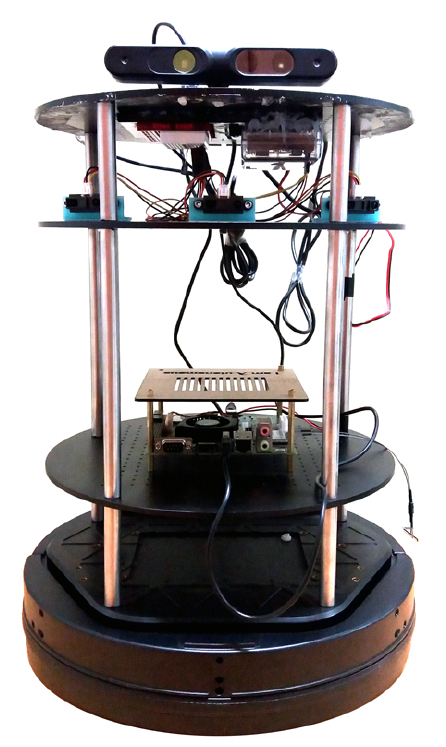
Figure 11. Our simulated robot in Gazebo simulation environment.